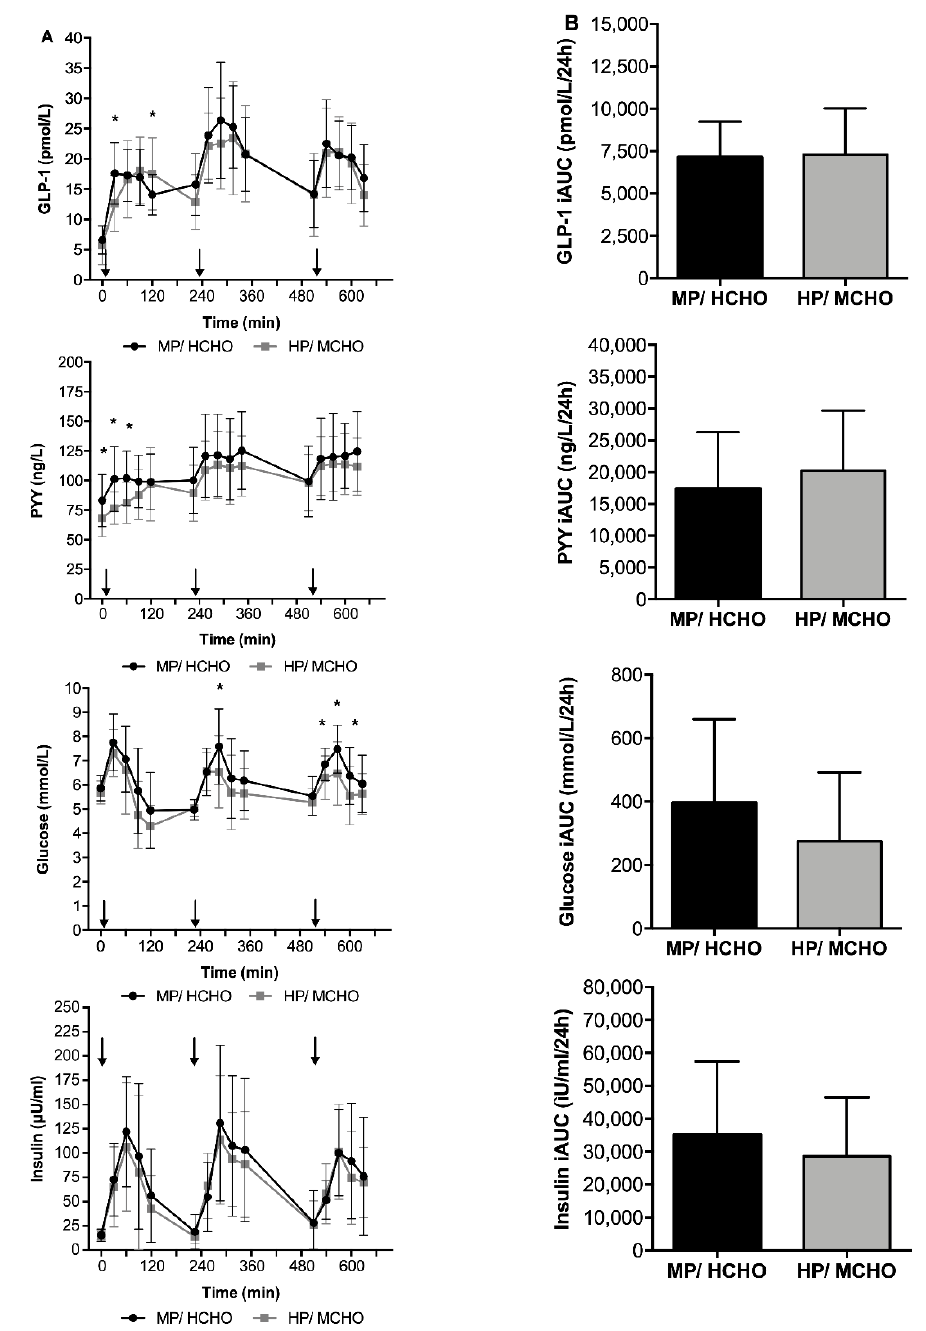
Figure 4. ( A ) Postprandial responses over time and ( B ) incremental area under the curves of GLP-1, PYY, Figure 4. (A) Postprandial responses over time and (B) incremental area under the curves of GLP-1, glucose, and insulin in the MP / HCHO (black) and HP / MCHO (grey) group. Arrows indicating timepoint PYY, glucose, and insulin in the MP/HCHO (black) and HP/MCHO (grey) group. Arrows indicating of meals. * p < 0.05. Values are means ± SD. Di ff erences between groups were calculated with a One-Way timepoint of meals. * p < 0.05. Values are means ± SD. Differences between groups were calculated ANOVA. MP / HCHO = moderate protein / high carbohydrate; HP / MCHO = high protein / moderate with a One-Way ANOVA. MP/HCHO = moderate protein/high carbohydrate; HP/MCHO = high carbohydrate; GLP-1 = glucagon-like peptide 1; PYY = peptide YY; iAUC = incremental area under protein/moderate carbohydrate; GLP-1 = glucagon-like peptide 1; PYY = peptide YY; iAUC = the incremental area under the curve.